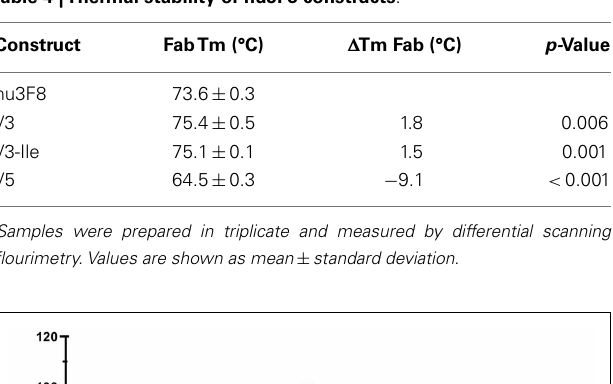
Table 4 |Thermal stability of hu3F8 constructs .